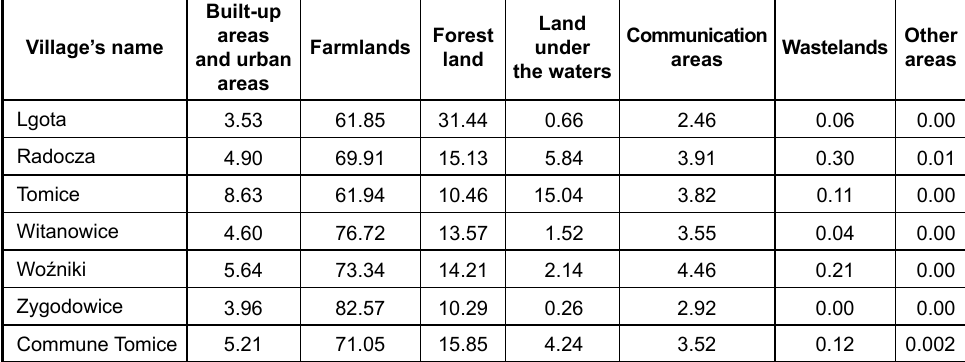
Table 4. The structure of land use in the commune of Tomice (percentages)